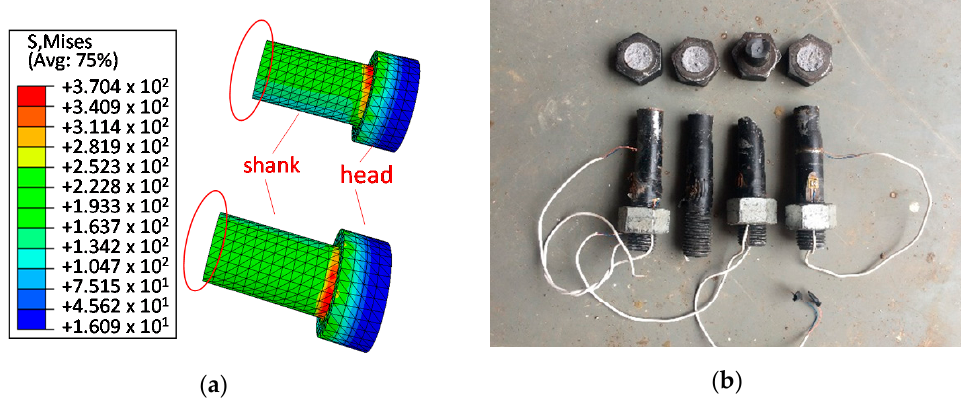
Figure 16. Bolts in the model and tests: ( a ) calculated bolt stress concentration in the model (33 mm diameter); ( b ) failed bolts in tests.